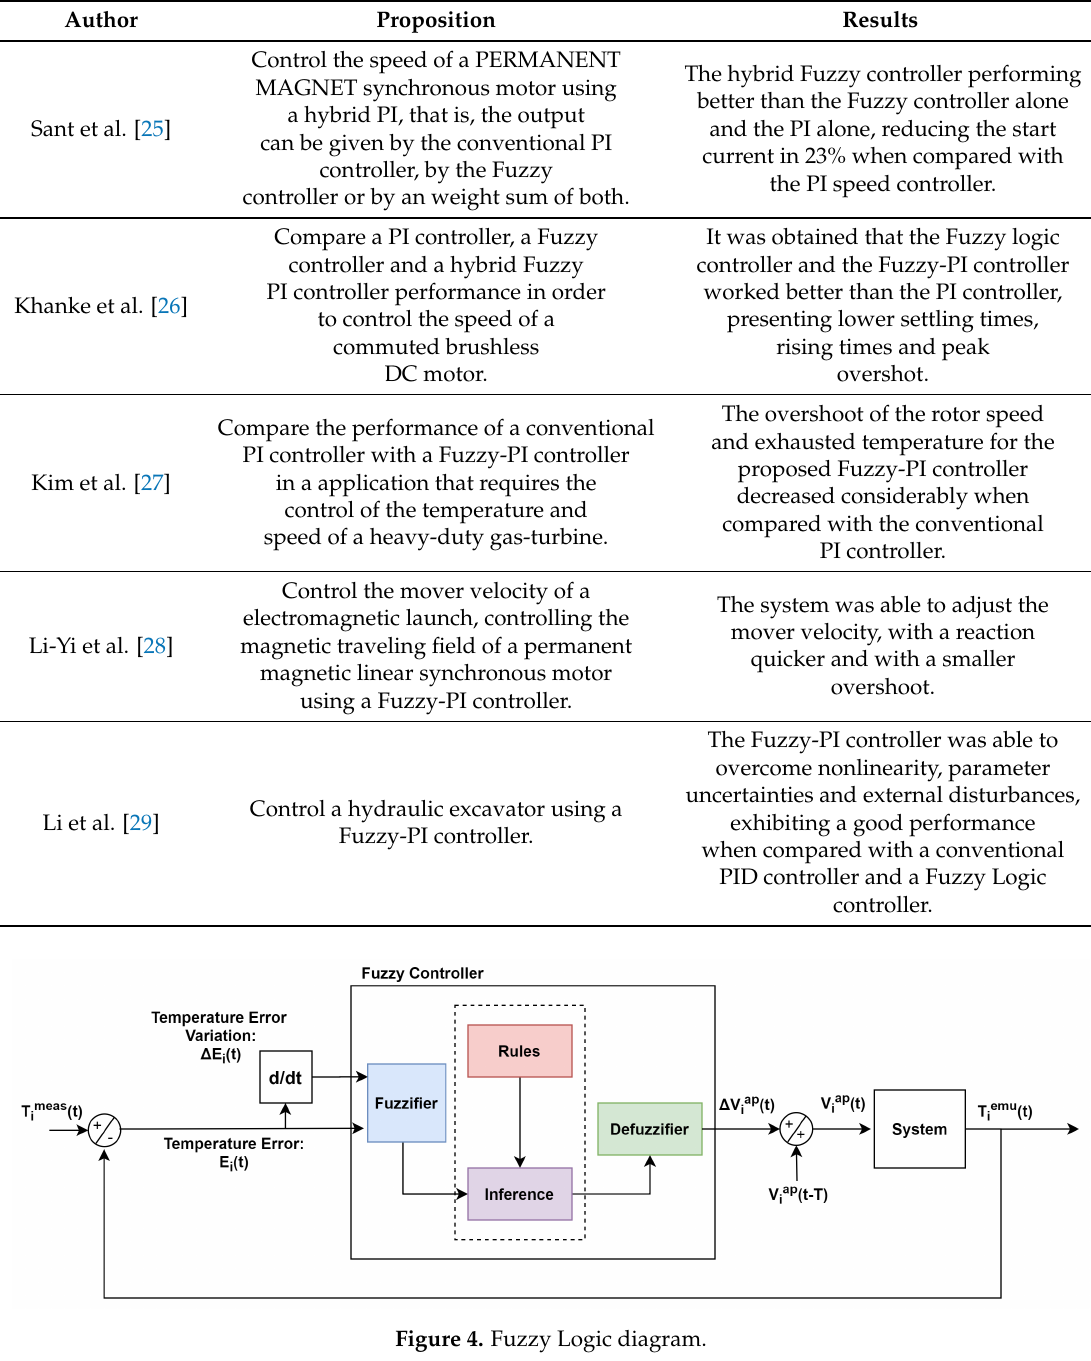
Figure 4. Fuzzy Logic